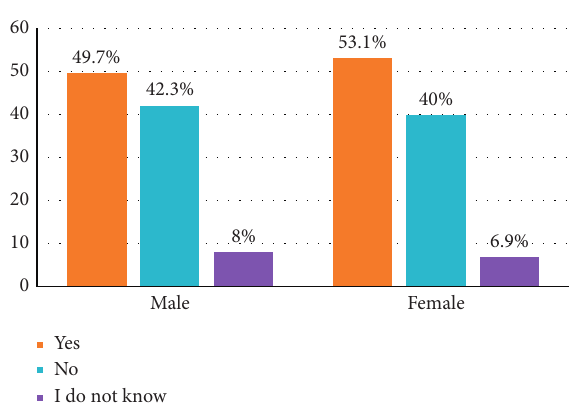
Figure 1: Respondents’ encounter with natural